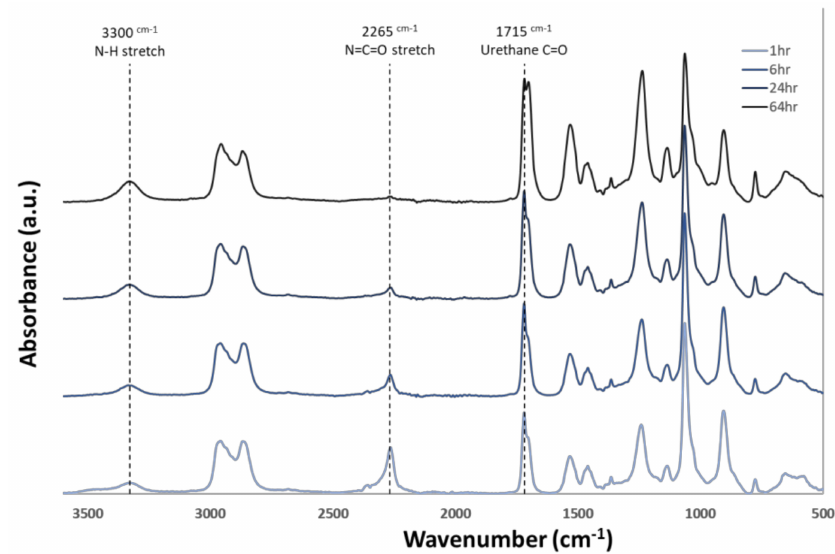
Figure 2. Attenuated total reflectance Fourier transform infrared (ATR − FTIR) spectra of thermoplastic over the duration of the synthesis process. Reduction of the isocyanate peak at 2265 cm − 1 and an increase of urethane linkage groups at 1715 cm − 1 and 3300 cm − 1 can be seen as the reaction proceeds.